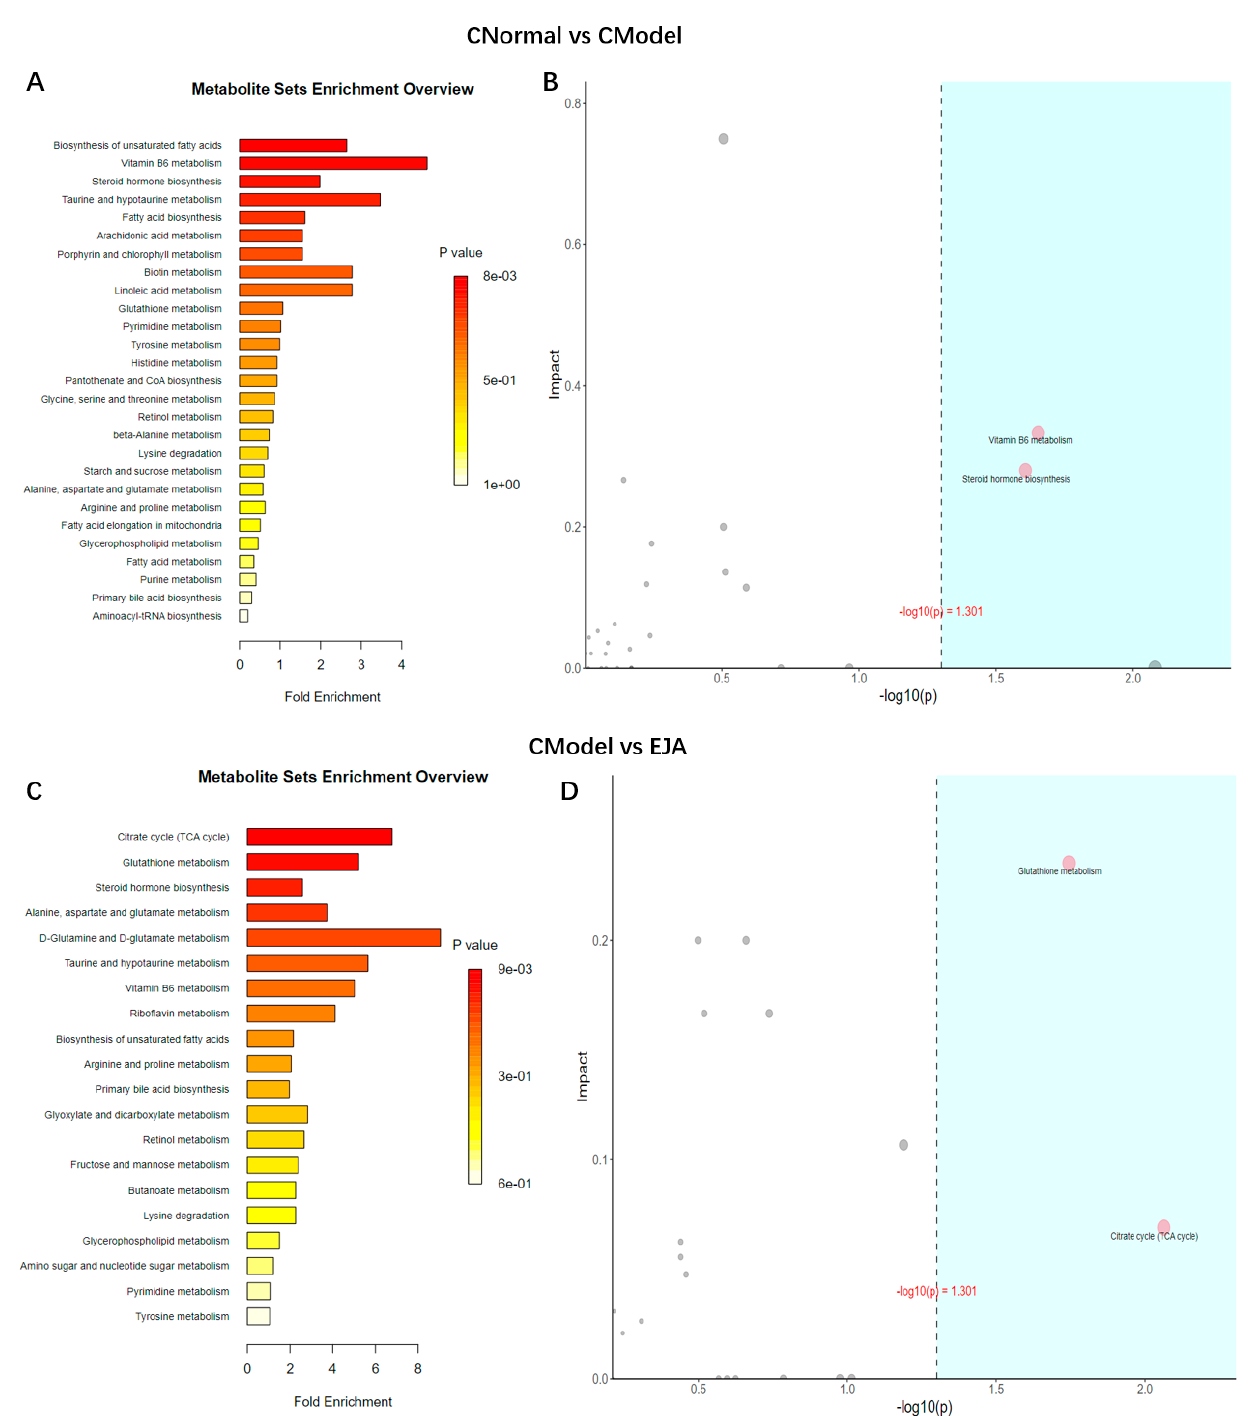
Figure 8. Metabolic pathway analysis. ( A ) Enrichment analysis of normal group and model group. ( B ) Topology analysis of normal group and model group. ( C ) Enrichment analysis of model group and drug administration group. ( D ) Topological analysis of model group and drug